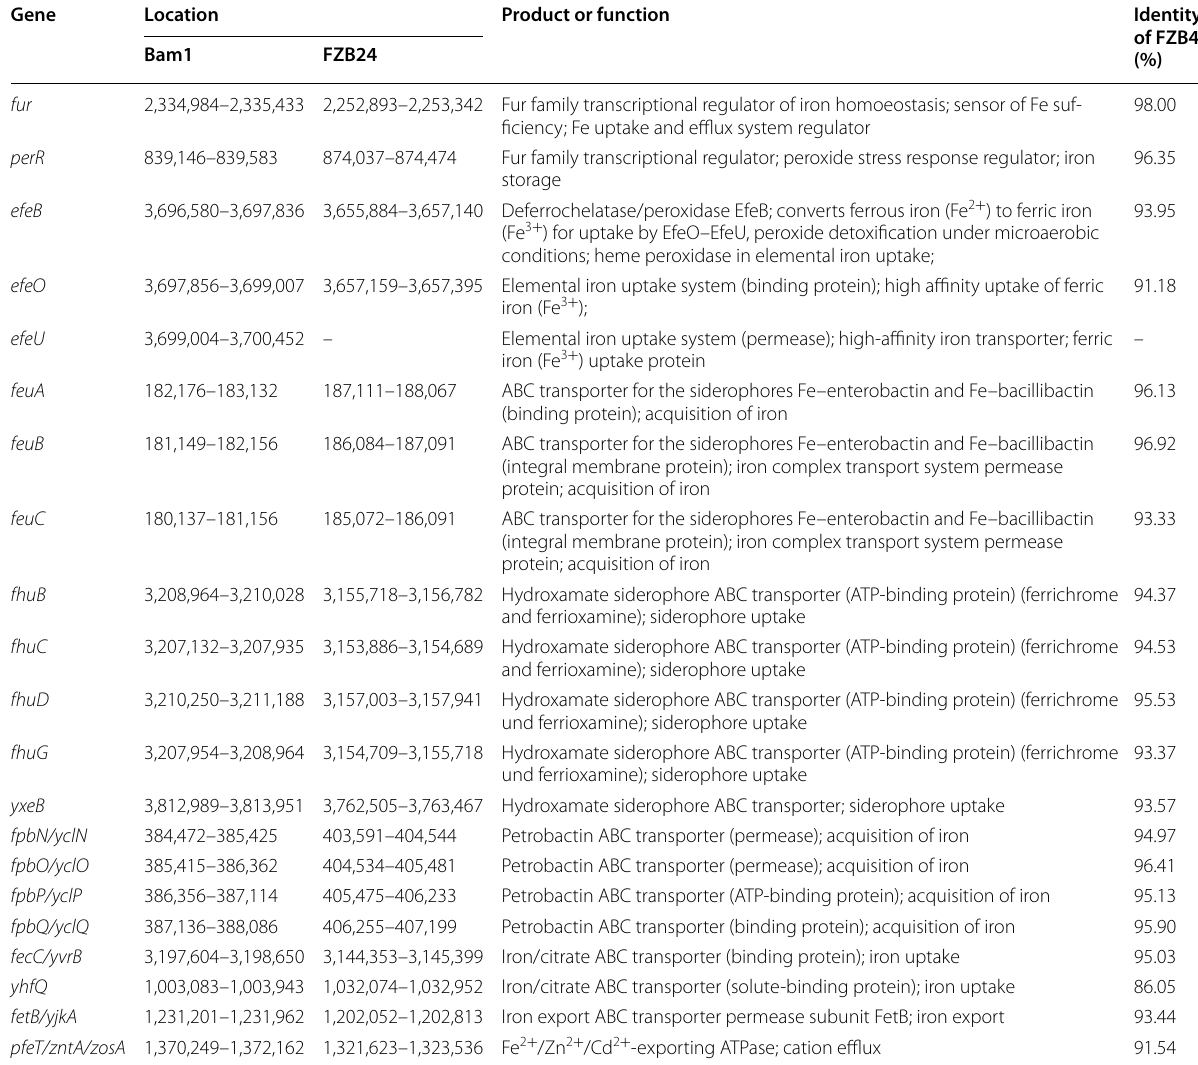
Table 4 Genes involved in Fe resistance in B. amyloliquefaciens strain Bam1 and B. velezensis strain FZB42 Gene